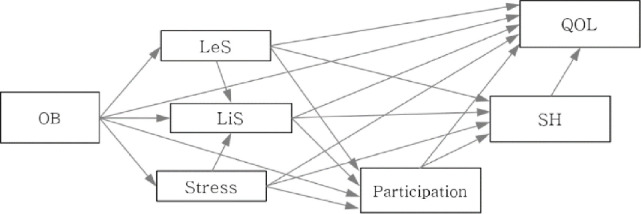
Conceptual framework.OB = occupational balance; LeS = leisure satisfaction; LiS = life satisfaction; SH = subjective health; QOL = quality of life.